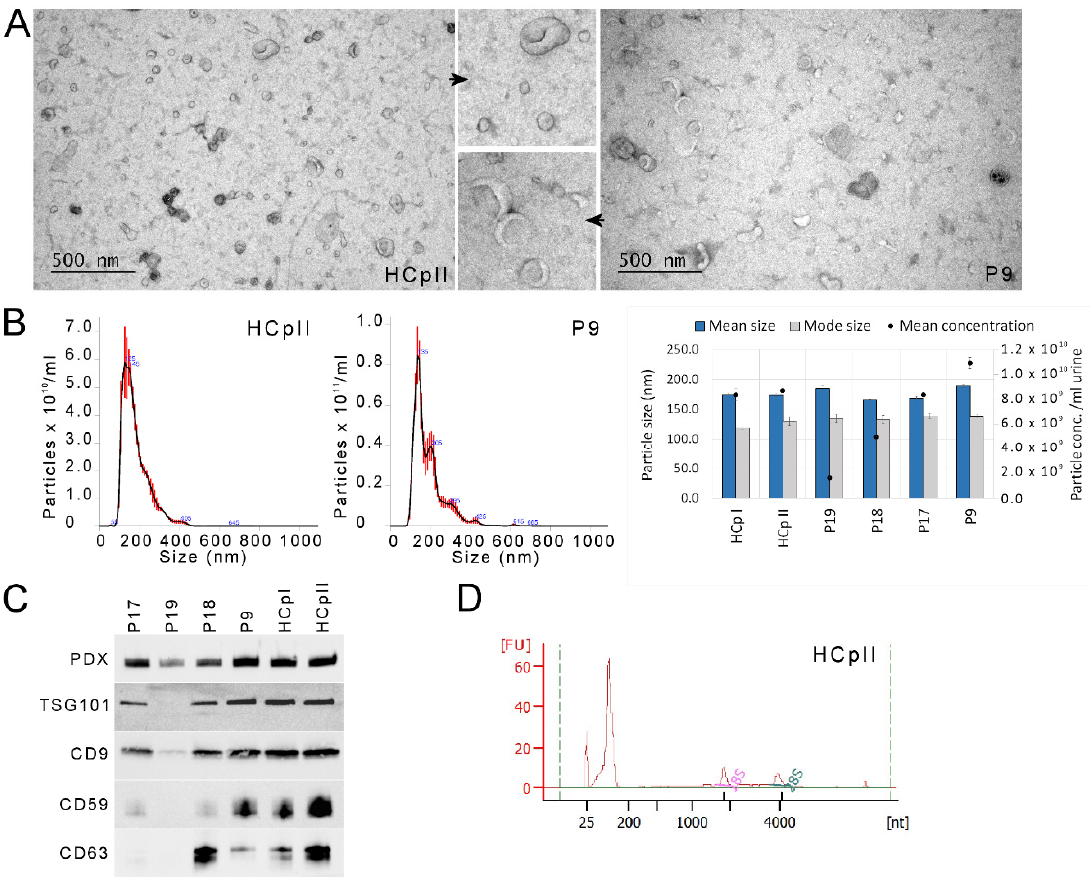
Figure 2. Quality control of uEV. ( A ) Representative electron micrographs (wide-field and close-up) and ( B ) representative nanoparticle tracking analysis histograms, as well as mean and mode size and mean concentration of particles in different study samples. ( C ) Same samples were subjected to analysis of uEV enriched protein markers by Western blotting. The uncropped Western blots have been shown in Figure S5. ( D ) Total RNA profile from HCpII uEV obtained by Bioanalyzer Pico assay. The status and progression groups of the patients were: P9—B and I, P17—C and II, P18—C and II, P19—C and III. Concentration (Conc.), healthy control pool I and II (HCpI and HCpII), patient (P), podocalyxin